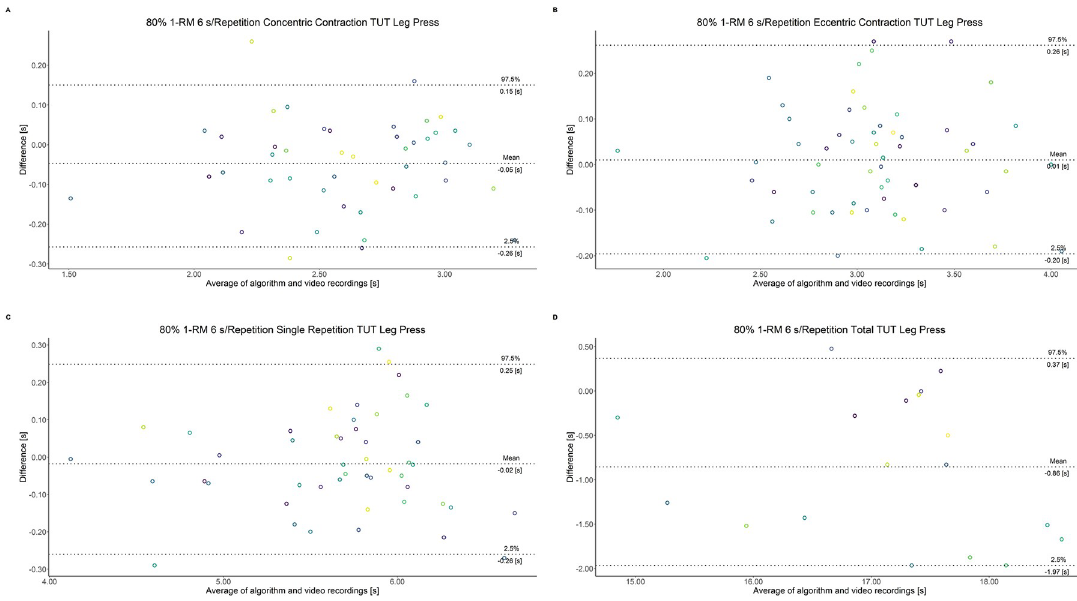
Fig 17. Bland-Altman plots of agreement between algorithmically accelerometer derived and video recordings derived contraction-specific phases of the leg press machine at 80% 1-RM with a velocity of 6 s per repetition. A: Concentric contraction phase. B: Eccentric contraction phase. C: Single repetition. D: Total time-under-tension.